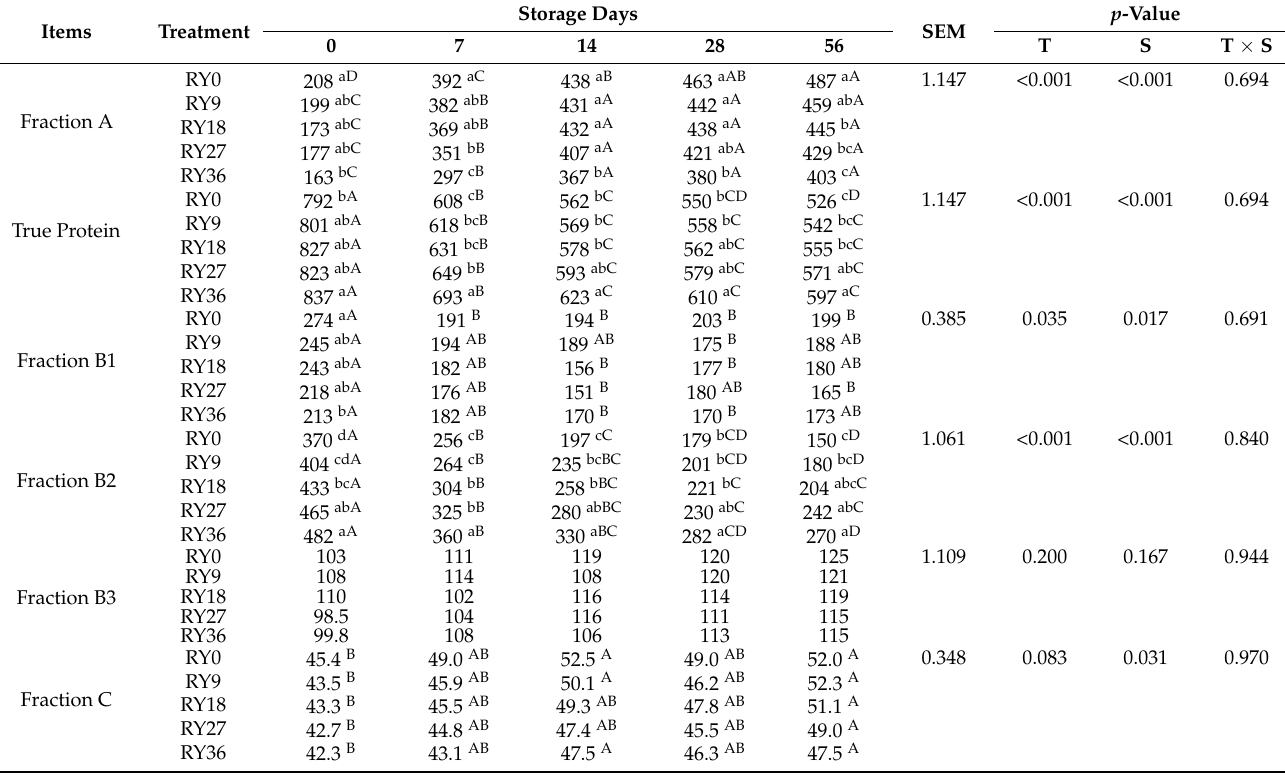
Table 7. Effect of paper mulberry replacement levels and storage days on the protein fraction of TMR silages (g/kg